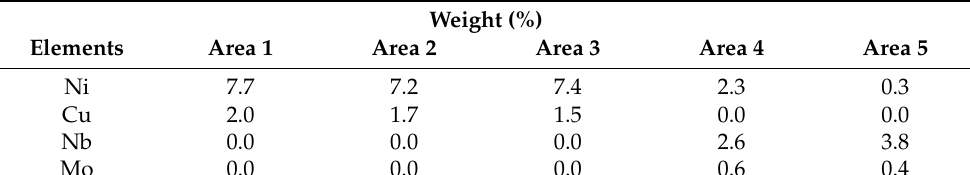
Figure 12. Schematic diagram of EDS measurement area : (1) 303Cu BM, (2) top of weld, (3) Bottom of weld, (4) Heat-affected zone, (5) 440C-Nb BM . Table 3. Comparison of alloy element composition in each area.